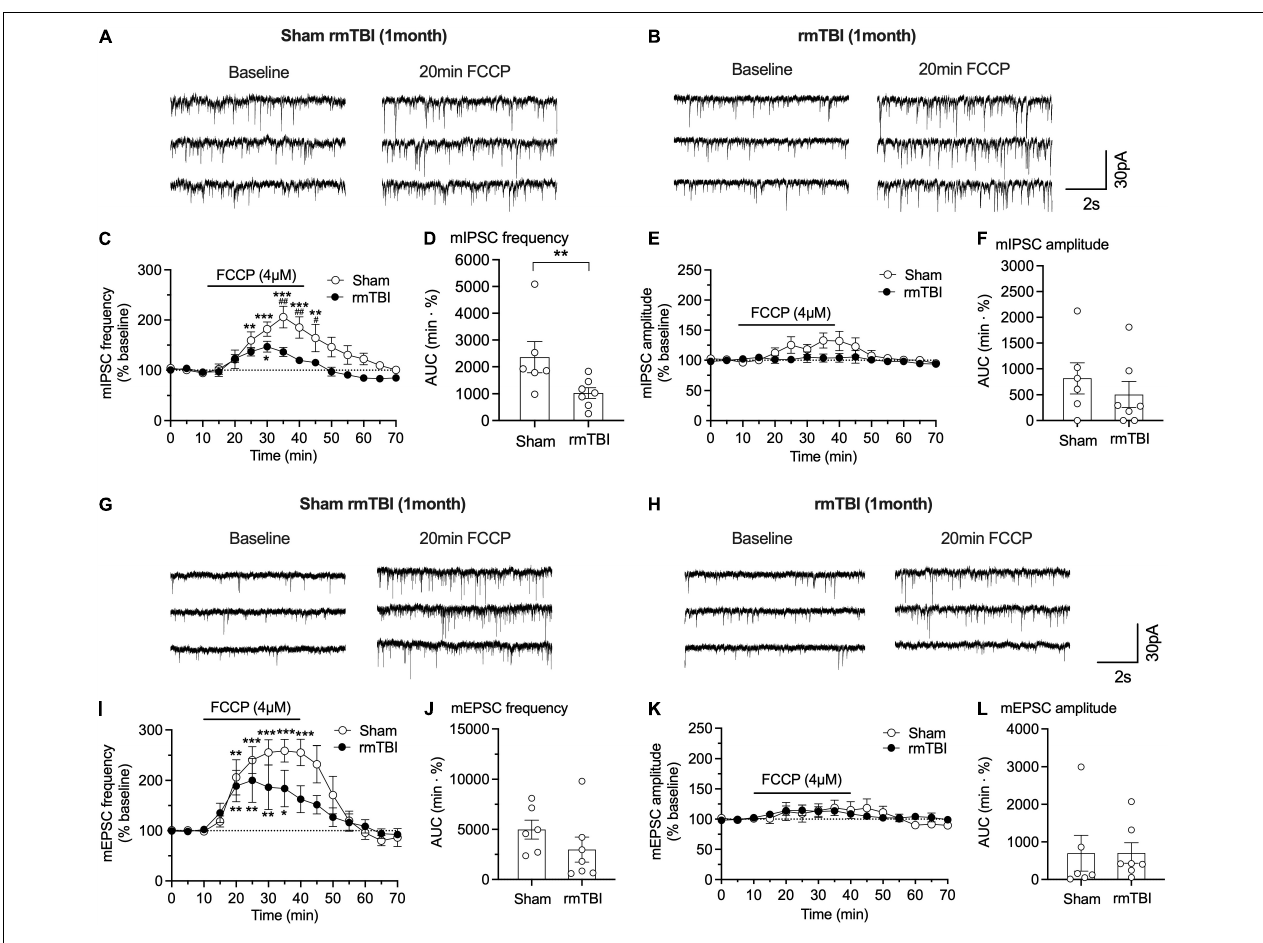
FIGURE 10 | FCCP on synaptic transmission in mPFC after rmTBI. (A,B) Representative traces of effects of FCCP on mIPSC from rats 1 month after rmTBI and time-matched sham/control rats. Effects of FCCP on frequency (C,D) and amplitude (E,F) of mIPSC. (G,H) Representative traces of effects of FCCP (4 µ M) on mIPSC from rats 1 month after mTBI and time-matched sham/control rats. Effects of FCCP on frequency (I,J) and amplitude (K,L) of mEPSC. Each dot in (D,F,J,L) represents data from one neuron. Recordings were obtained from 8 rats, 4 sham rats, and 4 rmTBI treated rats. * P < 0.05, ** P < 0.01, *** P < 0.001 in (B,F) were compared to baseline at 0–10 min with 2-way repeated measure ANOVA and Bonferroni correction. # P < 0.05, ## P < 0.01 in (B,F) were compared to FCCP perfusion time-matched rmTBI rats with 2-way repeated measure ANOVA and Bonferroni correction. ** P < 0.01 in (C) was by t